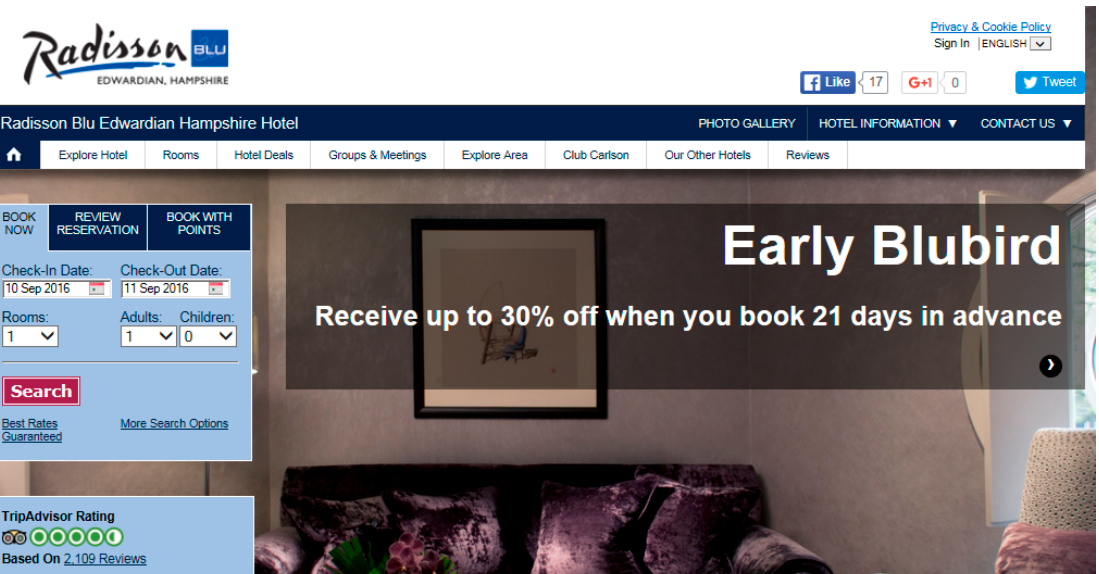
Figure A2. The rating is ‘one-click away’ or a distinct link exists to their TripAdvisor rating.